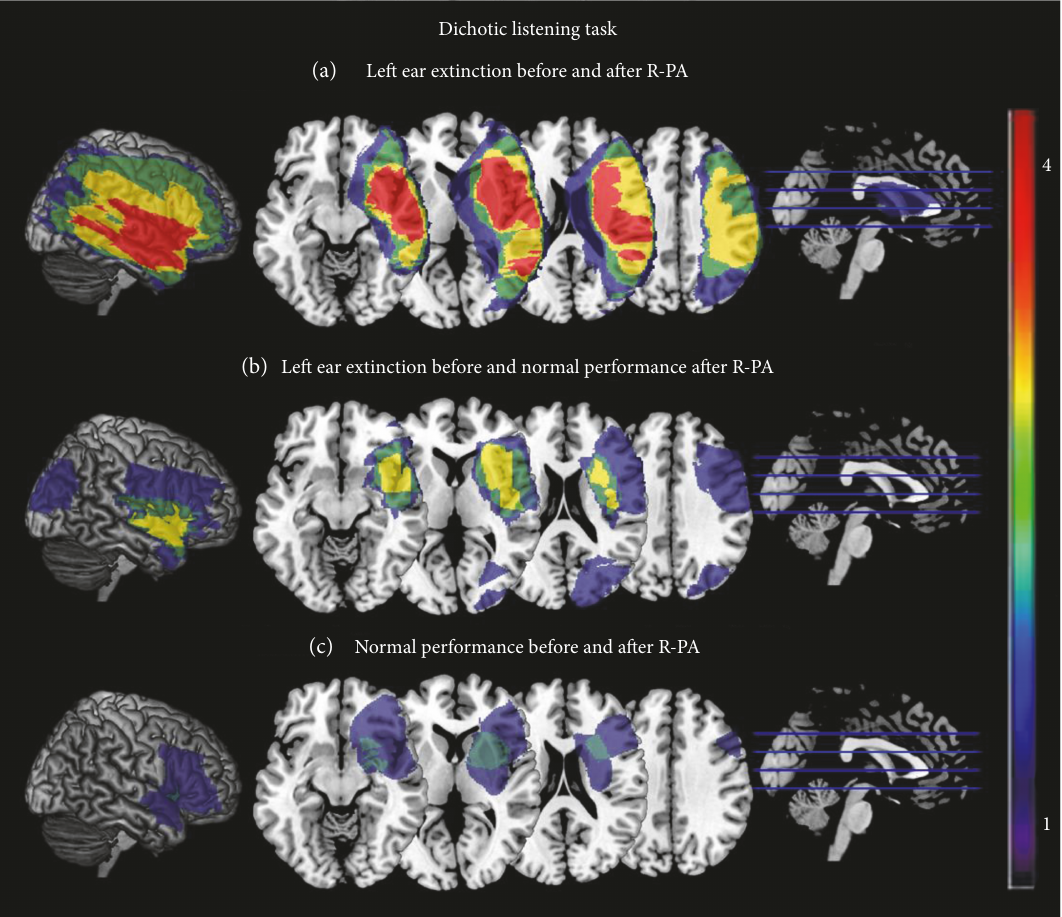
Figure 2: Anatomical correlates of performance in dichotic listening task. Superposition of lesions associated with 3 pro fi les: (a) Patients with left ear extinction who did not respond to R-PA (P1, P2, P4, and P9). (b) Patients with left ear extinction who responded to R-PA (P3, P5, P6, and P8). (c) Patients without de fi cits at the dichotic listening task (P7 and